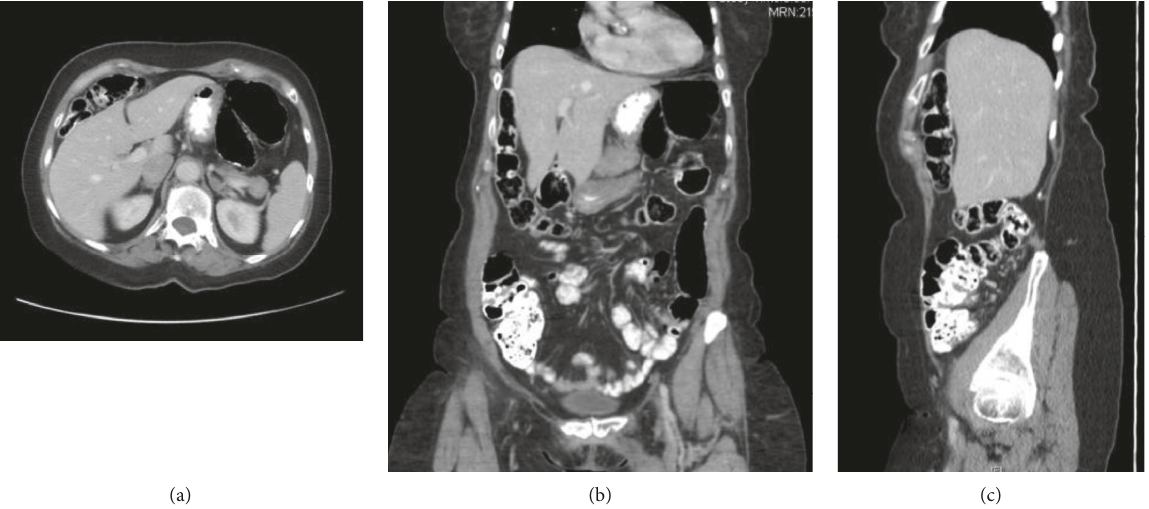
Figure 2: (a) Axial, (b) coronal, and (c) sagittal images from the patient’s 2017 CTabdomen and pelvis demonstrating colon anterior to the